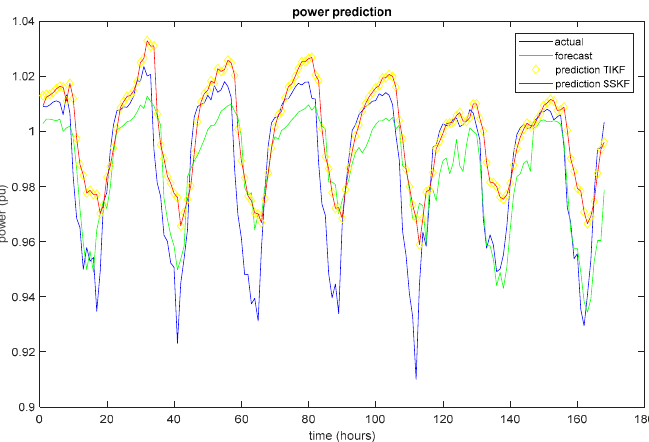
Figure 6. Power generation prediction with the Kalman Filter (KF) using the linear model.